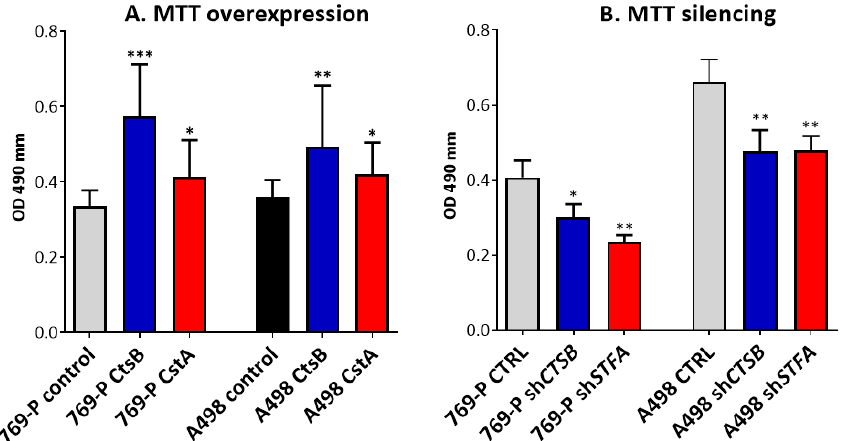
Figure 7. Effect of CtsB and StfA overexpression and silencing on the proliferation of RCC-derived cells. Cell proliferation following ( A ) CtsB/StfA overexpression and ( B ) CtsB/StfA silencing were analyzed through MTT assay. Proliferation was measured at 72 h after transfections of 769-P and A498 cells. Cells seeded in 96-well plates were treated with (3-(4,5-dimethylthiazol-2-yl)-2,5- diphenyltetrazolium bromide) (MTT) for 6 h at 37 ◦ C. MTT was soluble and measured at 450 nm to determine the number of viable cells. Results were analyzed by the U Mann–Whitney test and presented as the mean ± SEM of at least three independent experiments; * p < 0.05, ** p < 0.01, and *** p <